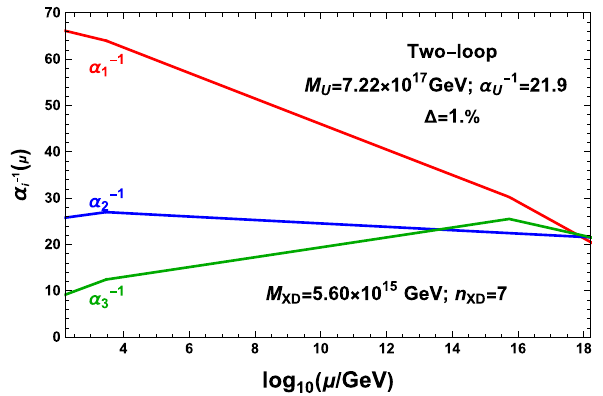
Fig. 2 Gauge coupling unification at 7 . 22 × 10 17 GeV for Model 2